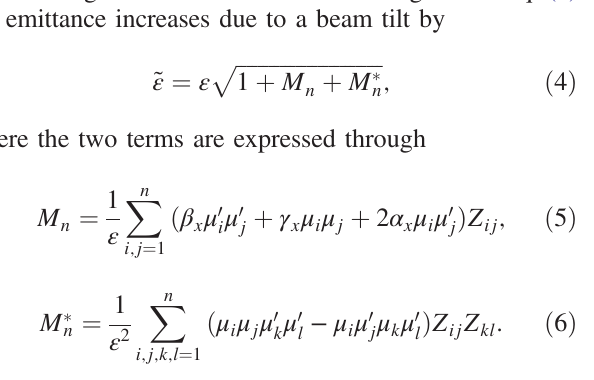
~ β because μ ¼ 0